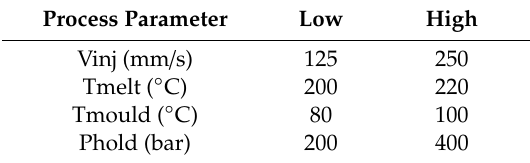
Table 3. Process parameter settings for the design of experiments (DoE) plan.